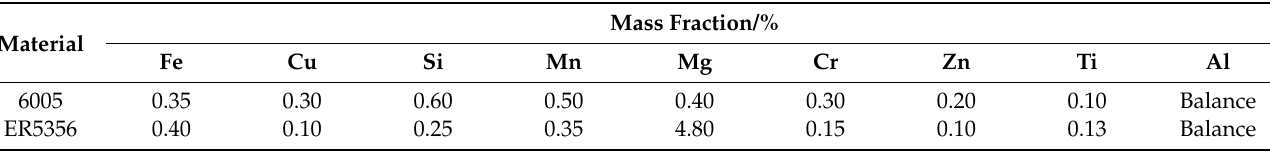
Table 1. Chemical composition of 6005 aluminum alloy and welding wire.